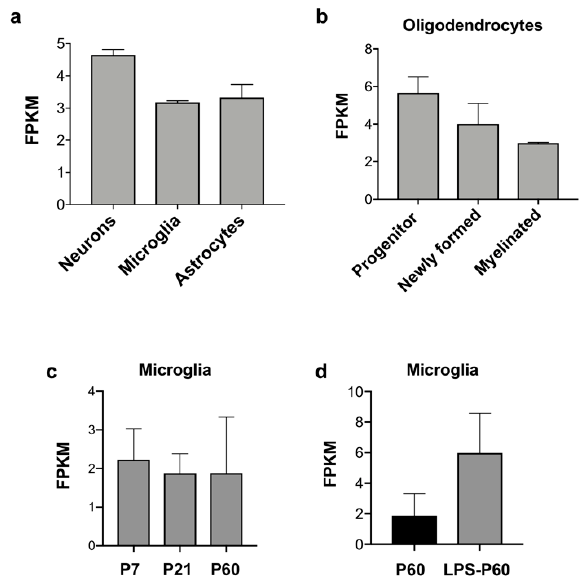
Figure 3. Wwox expression in mouse brain cell types. Bar graphs representing Wwox cell-type-specific expression levels, obtained from a mouse brain RNA-seq database (www.BrainRNAseq.org) [22,23] in ( a ) neurons, microglia, astrocytes, and ( b ) oligodendrocytes. Within the oligodendrocyte population, the highest Wwox expression levels are seen in progenitor oligodendrocytes, followed by newly formed and myelinated oligodendrocytes. ( c ) Uniform Wwox expression is observed at P7, P21, and P60 in microglial cells. ( d ) Wwox expression is upregulated upon LPS treatment. Y-axis represents Wwox expression as fragments per kilobase of transcript per million mapped reads (FPKM), error bars represent ± SD.